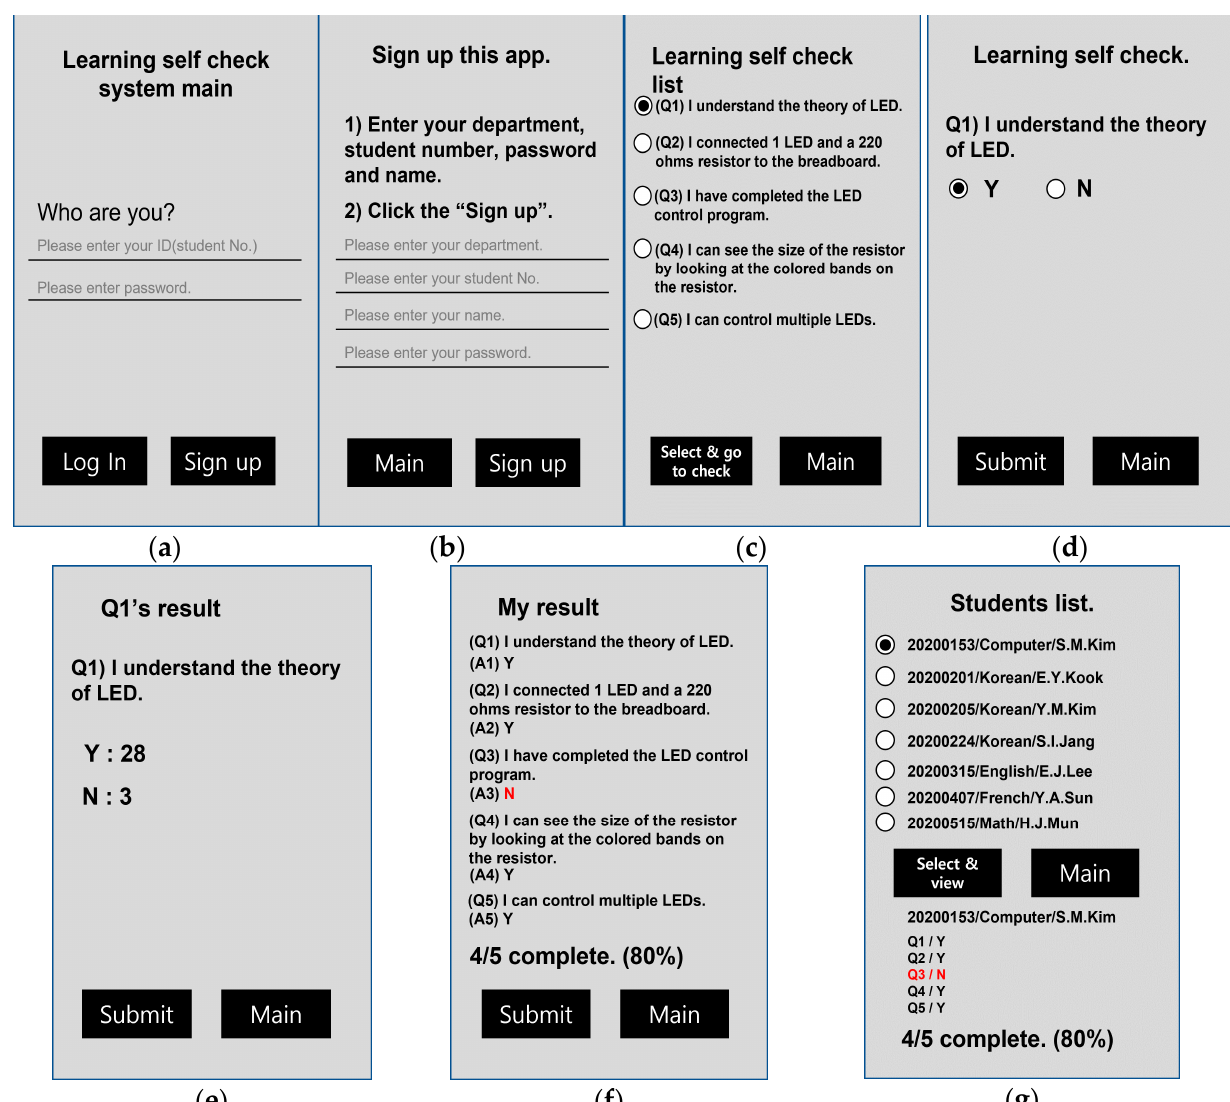
Figure 4. Development of the mobile application, ( a ) is the first screen to run in the mobile application, and functions to connect to the main page, login, and member registration. ( b ) is the membership registration menu. ( c ) is a menu for selecting an item. ( d ) is a menu that students check for questions. ( e ) is a menu for the teacher to view statistics for a specific question. ( f ) is a menu in which learners self-check all items. ( g ) is a menu that allows the teacher to view all students and the progress of a specific student.